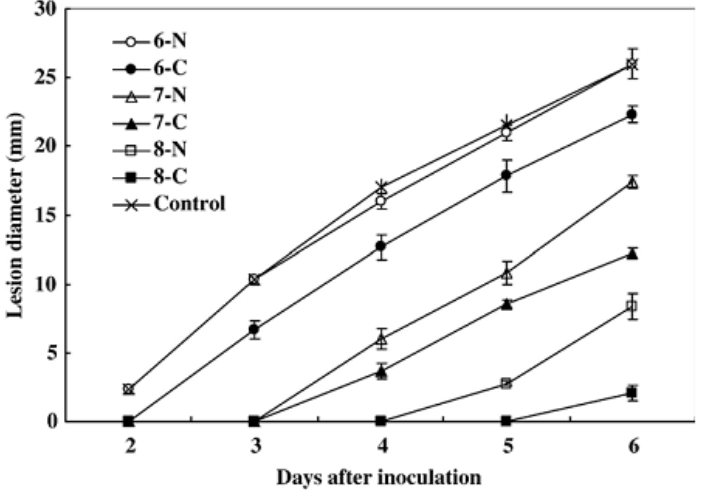
Figure 7. Efficacy of R. glutinis harvested from different media in controlling grey mould decay of strawberries. Each value is the mean of two experiments. Bars represent standard deviations. Different letters indicate significant differences ( P = 0.05) according to Duncan’s multiple range test and the data from each time point are separated. Reproduced from Reference